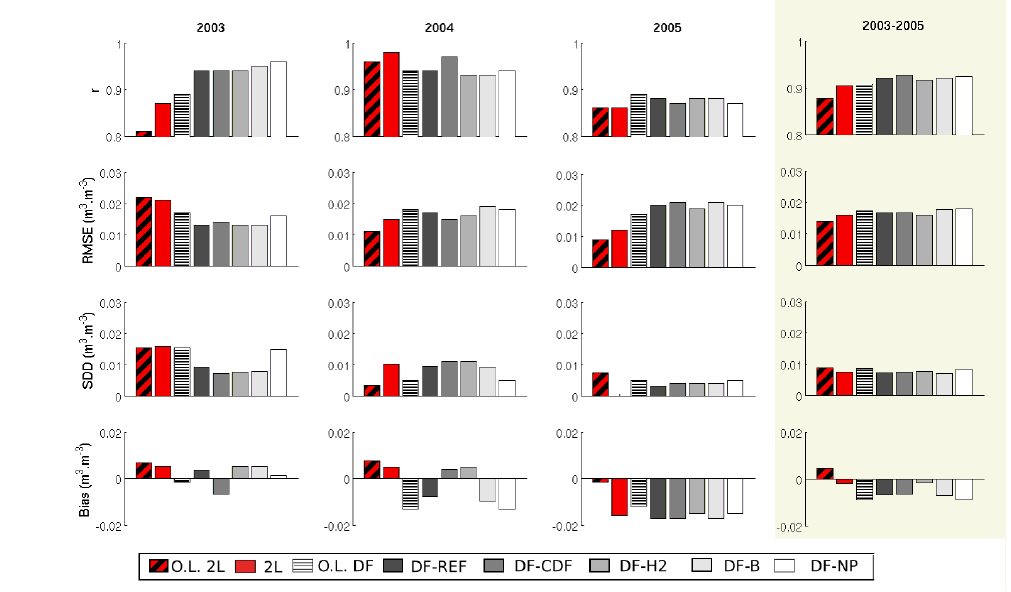
Fig. 5. Yearly and 3yr period statistical scores for w tot analysis for experiments presented in Table 1 and 2L experiment. O.L. means open-loop simulations.